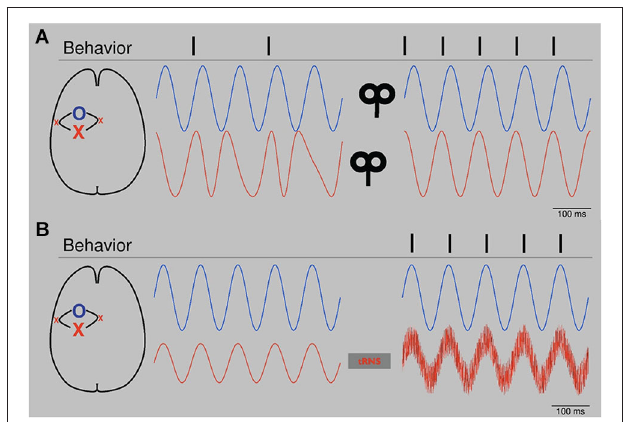
FIGURE 1 | (A) Schematic: Bifocal repetitive TMS (rTMS) restores alpha-band activity. After stroke, alpha oscillators (red line, left) of the affected area (red X, primary motor cortex) show unsteady phase properties. Since physiological behavior depends on a constant phase relation of alpha oscillations between the affected area and connected networks (blue O, blue line, left, premotor areas), the patient is impaired (behavior, left, e.g., muscle contractions). After application of bifocal, rTMS at alpha frequency over both areas with a lag reflecting physiological offset of oscillators, oscillatory activity is synchronized (blue and red line, right) in terms of a constant phase lag. Behavior improves (right). Please note that conditions are highly simplified. First, next to phase, also amplitude is important for signal processing. Second, in the presented physiological condition (right) phases are completely locked, which is artificial. Naturally, phases would fluctuate. (B) Schematic: tRNS augments alpha oscillators. After stroke alpha activity (red line, left) of the affected area (red X) is reduced. Threshold for establishing information processing with a related network (blue line, left) is not reached and dependent normal behavior is reduced. tRNS applied over the affected oscillator augments alpha activity by adding noise (red line, right). Information processing is re-established and behavior improves. Please note that conditions are very much simplified. In both cases, phase is totally locked without any phase lag. Biological signals would